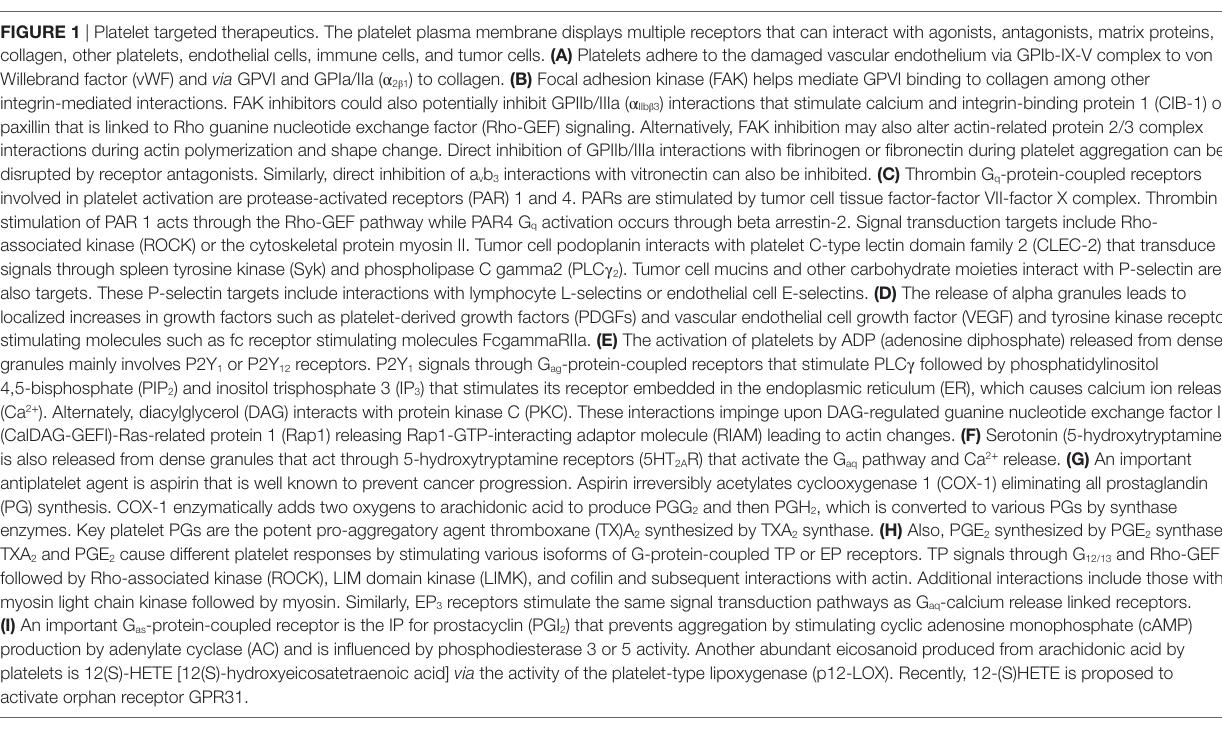
FiGURe 1 | Platelet targeted therapeutics. The platelet plasma membrane displays multiple receptors that can interact with agonists, antagonists, matrix proteins, collagen, other platelets, endothelial cells, immune cells, and tumor cells. (A) Platelets adhere to the damaged vascular endothelium via GPIb-IX-V complex to von Willebrand factor (vWF) and via GPVI and GPIa/IIa ( α 2 β 1 ) to collagen. (B) Focal adhesion kinase (FAK) helps mediate GPVI binding to collagen among other integrin-mediated interactions. FAK inhibitors could also potentially inhibit GPIIb/IIIa ( α IIb β 3 ) interactions that stimulate calcium and integrin-binding protein 1 (CIB-1) or paxillin that is linked to Rho guanine nucleotide exchange factor (Rho-GEF) signaling. Alternatively, FAK inhibition may also alter actin-related protein 2/3 complex interactions during actin polymerization and shape change. Direct inhibition of GPIIb/IIIa interactions with fibrinogen or fibronectin during platelet aggregation can be disrupted by receptor antagonists. Similarly, direct inhibition of a v b 3 interactions with vitronectin can also be inhibited. (C) Thrombin G q -protein-coupled receptors involved in platelet activation are protease-activated receptors (PAR) 1 and 4. PARs are stimulated by tumor cell tissue factor-factor VII-factor X complex. Thrombin stimulation of PAR 1 acts through the Rho-GEF pathway while PAR4 G q activation occurs through beta arrestin-2. Signal transduction targets include Rho- associated kinase (ROCK) or the cytoskeletal protein myosin II. Tumor cell podoplanin interacts with platelet C-type lectin domain family 2 (CLEC-2) that transduce signals through spleen tyrosine kinase (Syk) and phospholipase C gamma2 (PLC γ 2 ). Tumor cell mucins and other carbohydrate moieties interact with P-selectin are also targets. These P-selectin targets include interactions with lymphocyte L-selectins or endothelial cell E-selectins. (D) The release of alpha granules leads to localized increases in growth factors such as platelet-derived growth factors (PDGFs) and vascular endothelial cell growth factor (VEGF) and tyrosine kinase receptor stimulating molecules such as fc receptor stimulating molecules FcgammaRIIa. (e) The activation of platelets by ADP (adenosine diphosphate) released from dense granules mainly involves P2Y 1 or P2Y 12 receptors. P2Y 1 signals through G ag -protein-coupled receptors that stimulate PLC γ followed by phosphatidylinositol 4,5-bisphosphate (PIP 2 ) and inositol trisphosphate 3 (IP 3 ) that stimulates its receptor embedded in the endoplasmic reticulum (ER), which causes calcium ion release (Ca 2 + ). Alternately, diacylglycerol (DAG) interacts with protein kinase C (PKC). These interactions impinge upon DAG-regulated guanine nucleotide exchange factor I (CalDAG-GEFI)-Ras-related protein 1 (Rap1) releasing Rap1-GTP-interacting adaptor molecule (RIAM) leading to actin changes. (F) Serotonin (5-hydroxytryptamine) is also released from dense granules that act through 5-hydroxytryptamine receptors (5HT 2A R) that activate the G aq pathway and Ca 2 + release. (G) An important antiplatelet agent is aspirin that is well known to prevent cancer progression. Aspirin irreversibly acetylates cyclooxygenase 1 (COX-1) eliminating all prostaglandin (PG) synthesis. COX-1 enzymatically adds two oxygens to arachidonic acid to produce PGG 2 and then PGH 2 , which is converted to various PGs by synthase enzymes. Key platelet PGs are the potent pro-aggregatory agent thromboxane (TX)A 2 synthesized by TXA 2 synthase. (H) Also, PGE 2 synthesized by PGE 2 synthase. TXA 2 and PGE 2 cause different platelet responses by stimulating various isoforms of G-protein-coupled TP or EP receptors. TP signals through G 12/13 and Rho-GEF followed by Rho-associated kinase (ROCK), LIM domain kinase (LIMK), and cofilin and subsequent interactions with actin. Additional interactions include those with myosin light chain kinase followed by myosin. Similarly, EP 3 receptors stimulate the same signal transduction pathways as G aq -calcium release linked receptors. (i) An important G as -protein-coupled receptor is the IP for prostacyclin (PGI 2 ) that prevents aggregation by stimulating cyclic adenosine monophosphate (cAMP) production by adenylate cyclase (AC) and is influenced by phosphodiesterase 3 or 5 activity. Another abundant eicosanoid produced from arachidonic acid by platelets is 12(S)-HETE [12(S)-hydroxyeicosatetraenoic acid] via the activity of the platelet-type lipoxygenase (p12-LOX). Recently, 12-(S)HETE is proposed to activate orphan receptor